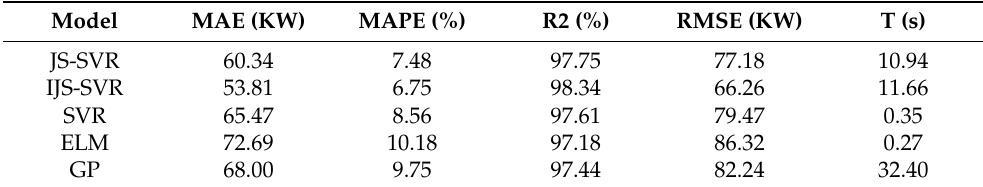
Table 6. Evaluation index values of each prediction model in